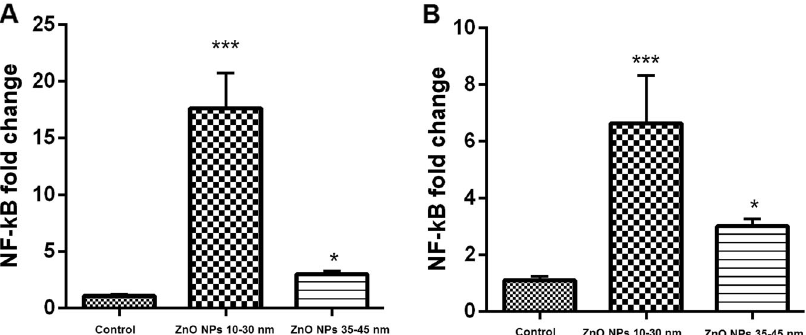
BMSCs ( B ) with ~10 – 30 and 35 – 45 ZnO NPs was signi fi cantly upregulated ( P ≤ 0.05 and P ≤ 0.001, respectively). The error bars show